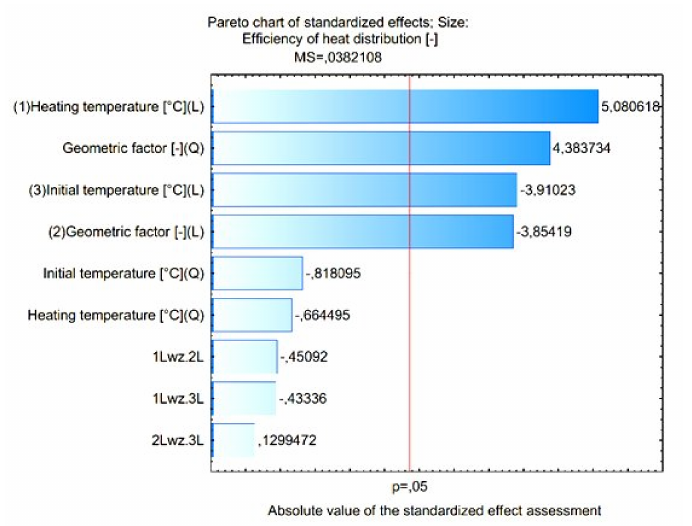
Figure 15. Pareto diagram of the influence of the analyzed input quantities and their correlation on the value of the output